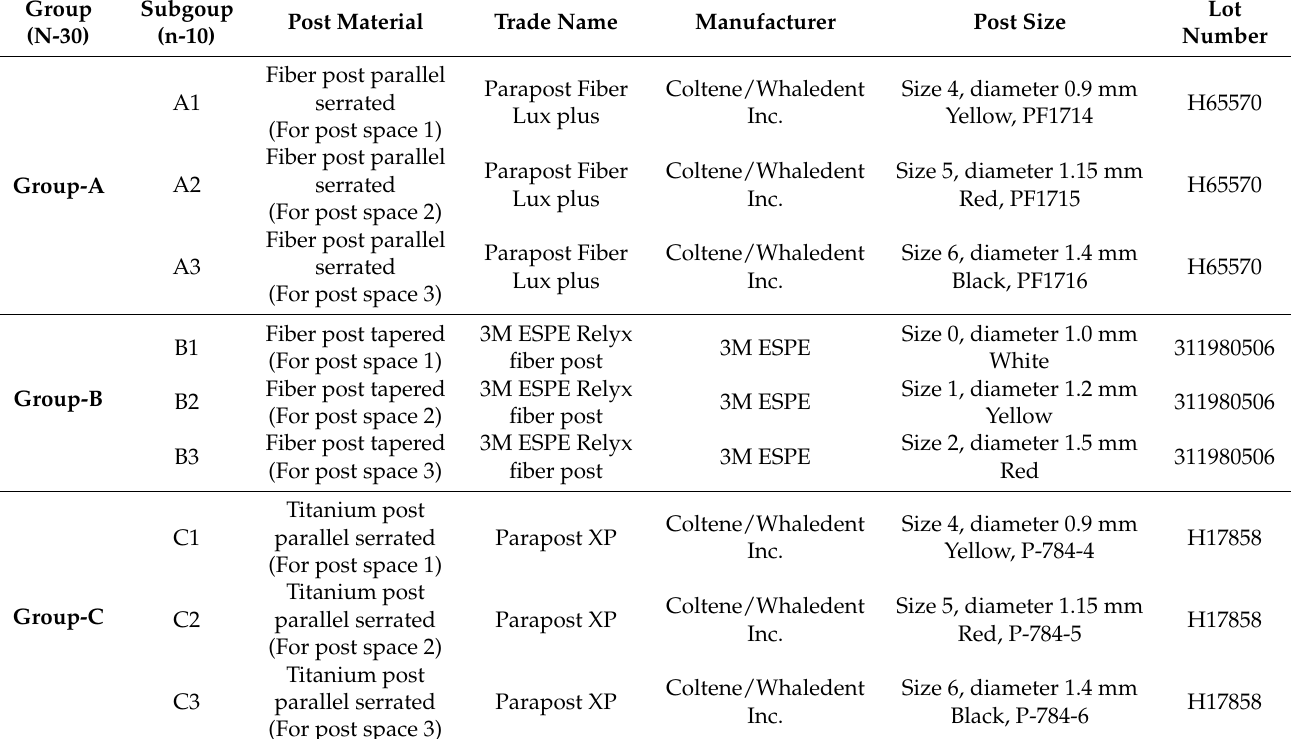
Table 1. Details of the tested post materials used for different groups in the research study.